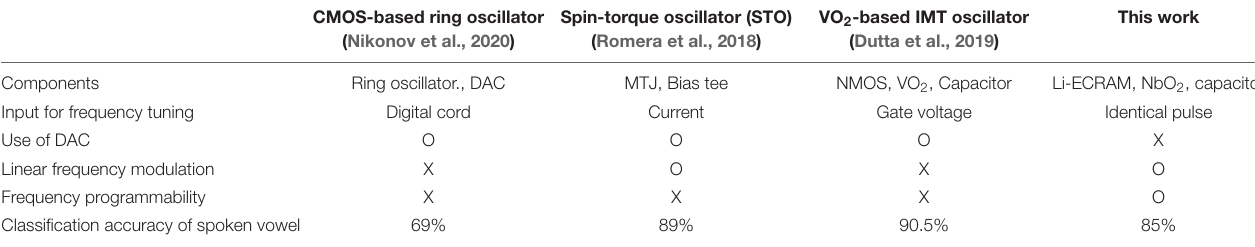
TABLE 1 | Benchmark of oscillators for spoken vowel classification.